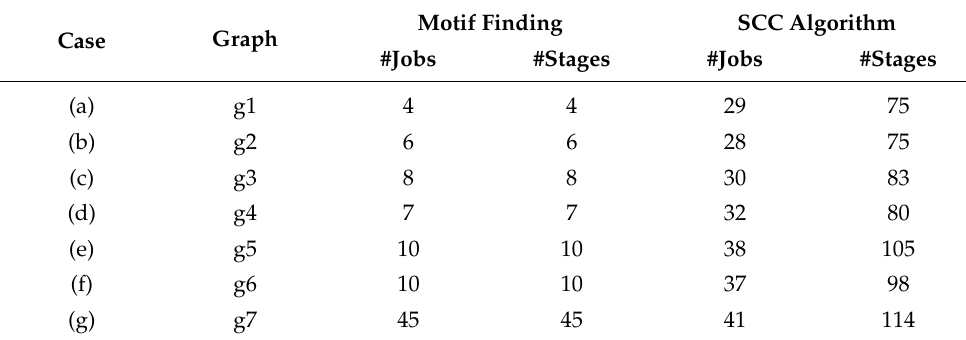
Table 1. Comparison of Spark jobs and stages.